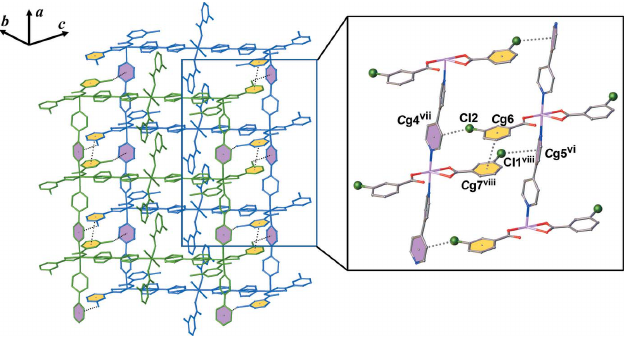
Figure 3 Views of the intermolecular (cid:2) – (cid:2) and Cl (cid:2)(cid:2)(cid:2) (cid:2) interactions between adjacent ladder chains [symmetry codes: (vi) x , (cid:4) 1 + y , z ; (vii) (cid:4) 1 + x , 1 + y , z ; (viii) 1 + x , (cid:4) 1 + y , z ]. the pyridine rings of 4,4 0 -bipy ligands with C24—Cl1 (cid:2) (cid:2) (cid:2) Cg 5 ( x ,